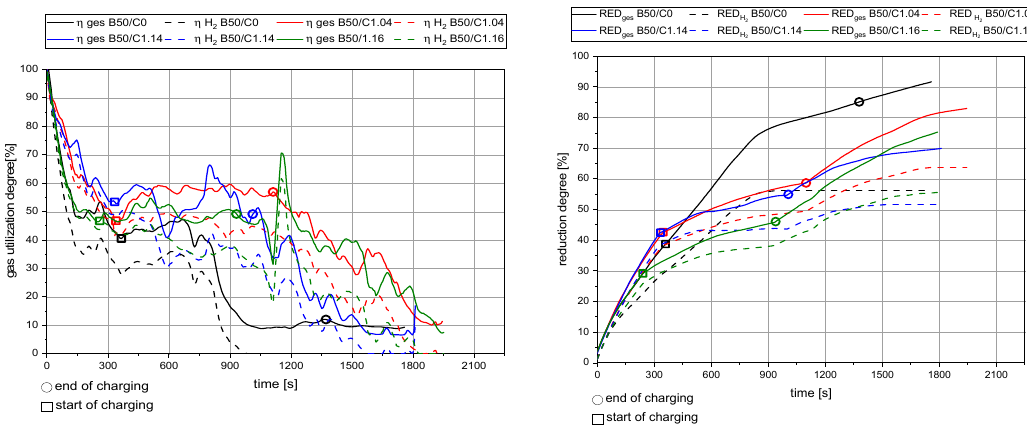
The increase in the RD’s gradient due to the cessation of charging (after the circle).